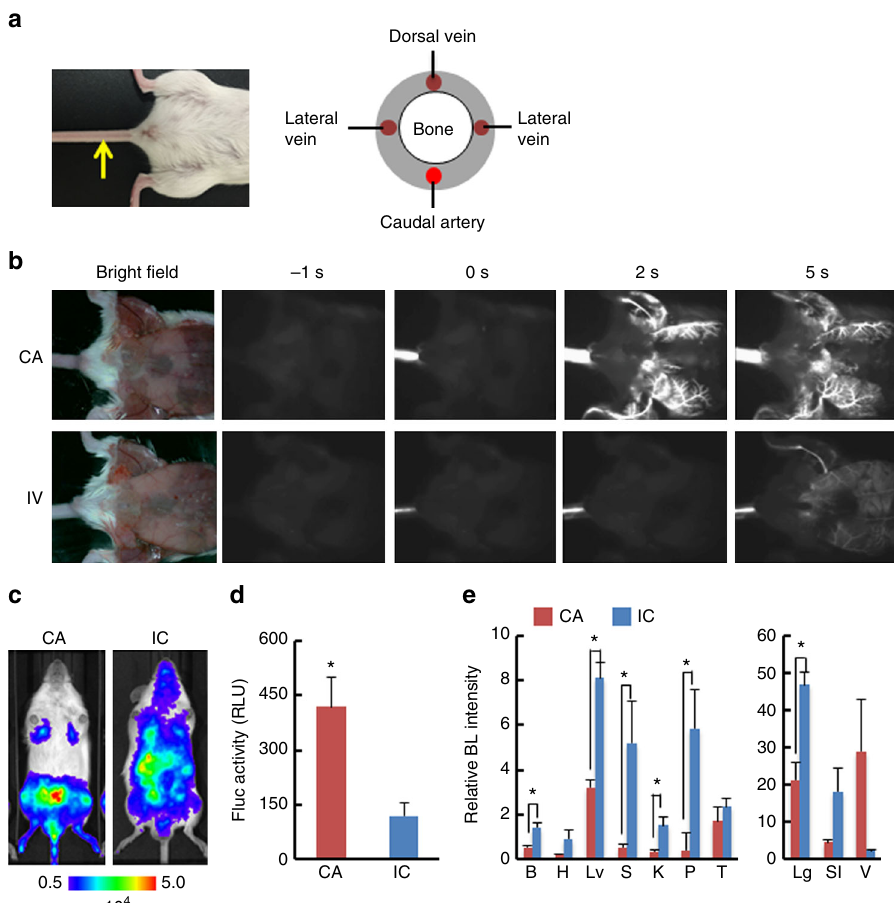
Fig. 1 CA injection ef fi ciently delivered cancer cells to bone marrow of a hind limb. a Location of caudal artery in a mouse (left) and a schematic of cross section of mouse tail (right). A yellow arrow indicates the caudal artery along the tail. b Comparison of fl uorescence images after intra-caudal artery (CA) or tail vein (IV) injection of near-infrared II nanoparticles. c Representative BL images at 30 min after injecting LLC/luc cells through caudal artery (CA)